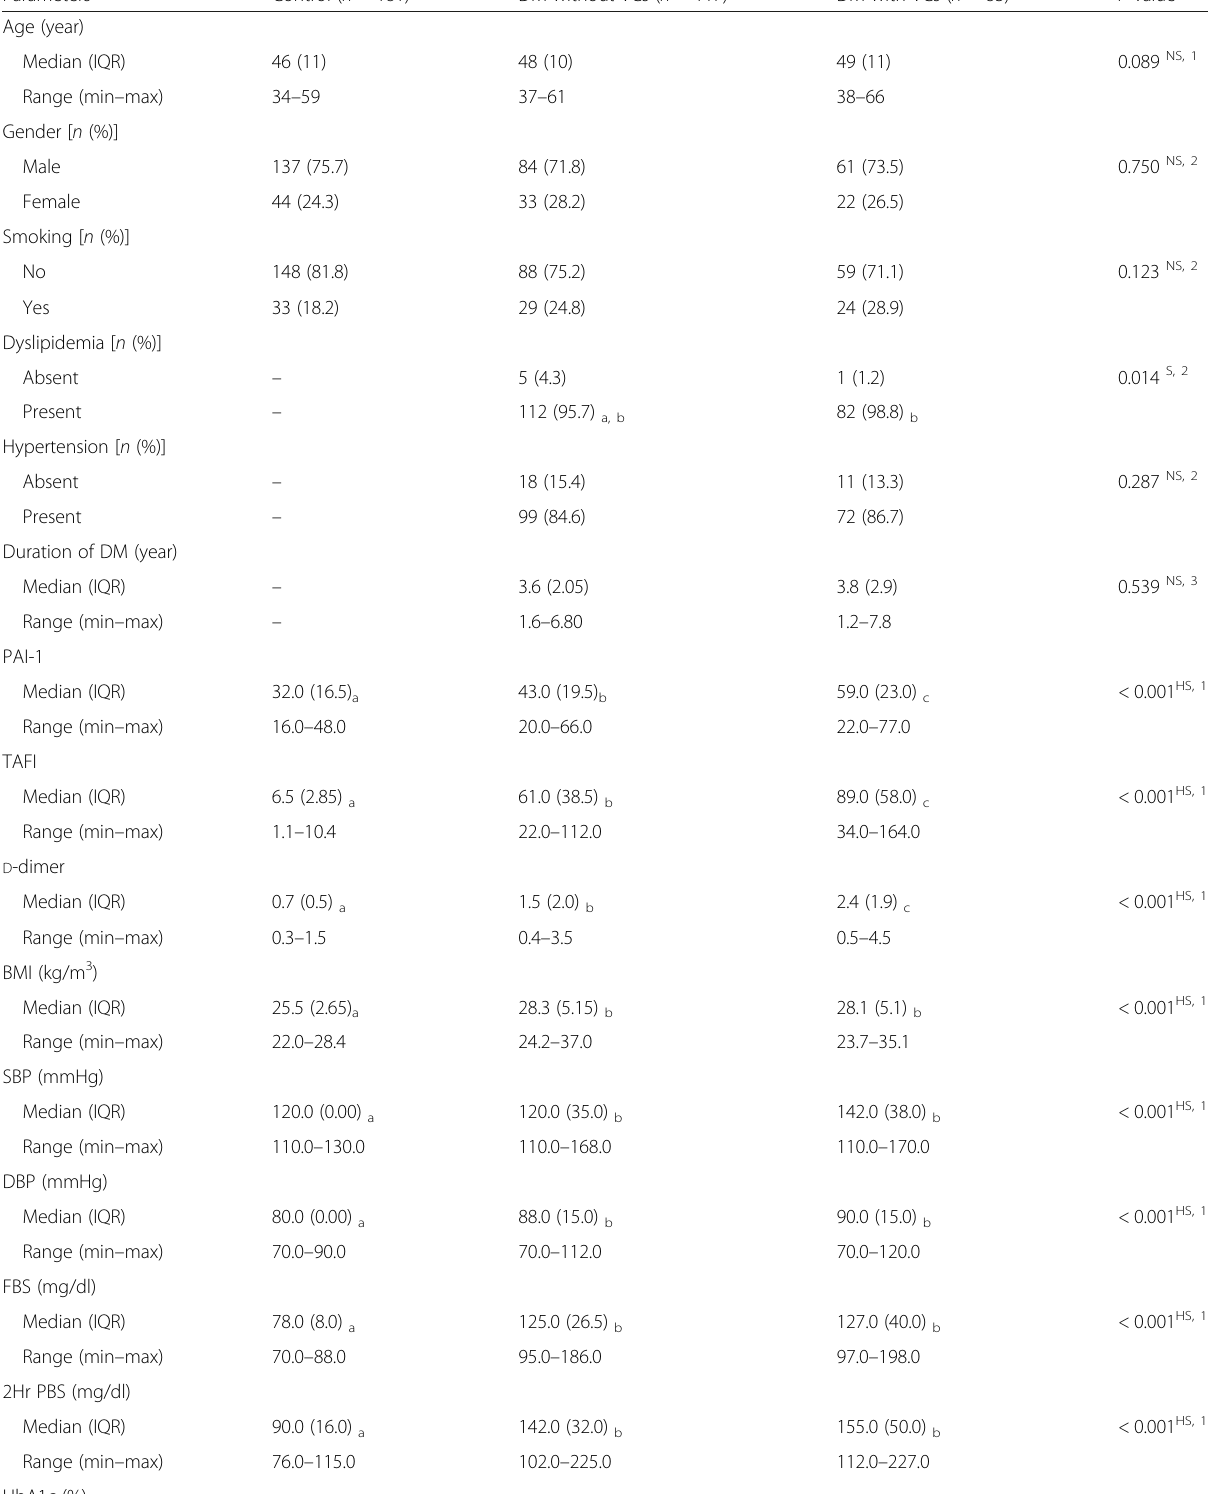
Table 1 Comparison between control, DM without vascular complications, and DM with vascular complications groups regarding demographic and clinical